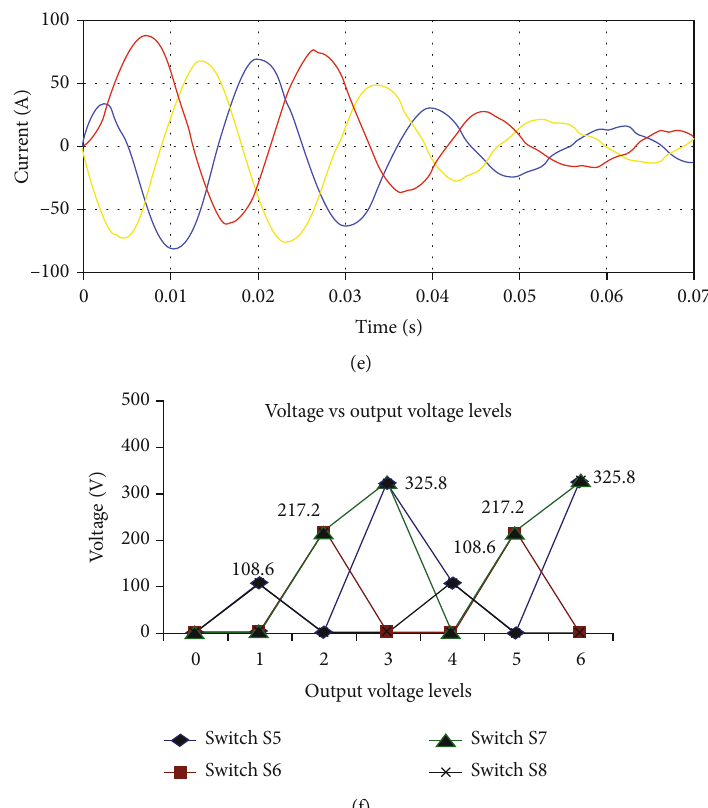
and S . (b) Voltage across H-bridge switches S 1 2